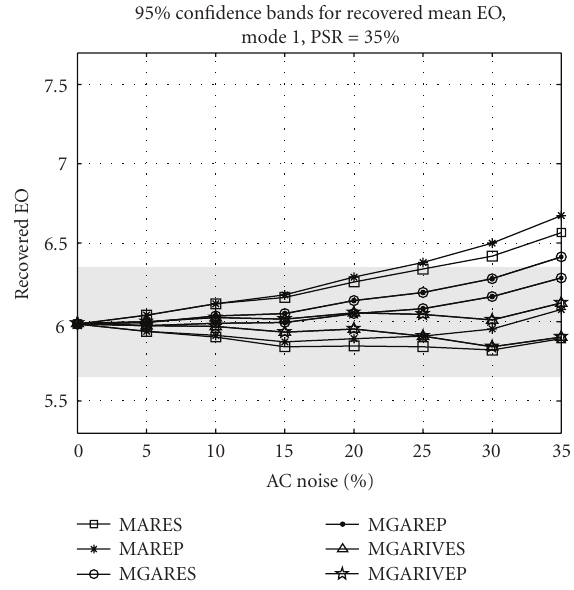
Figure 5: Test 1: 95% confidence bands for exact solution methods, mode 1.